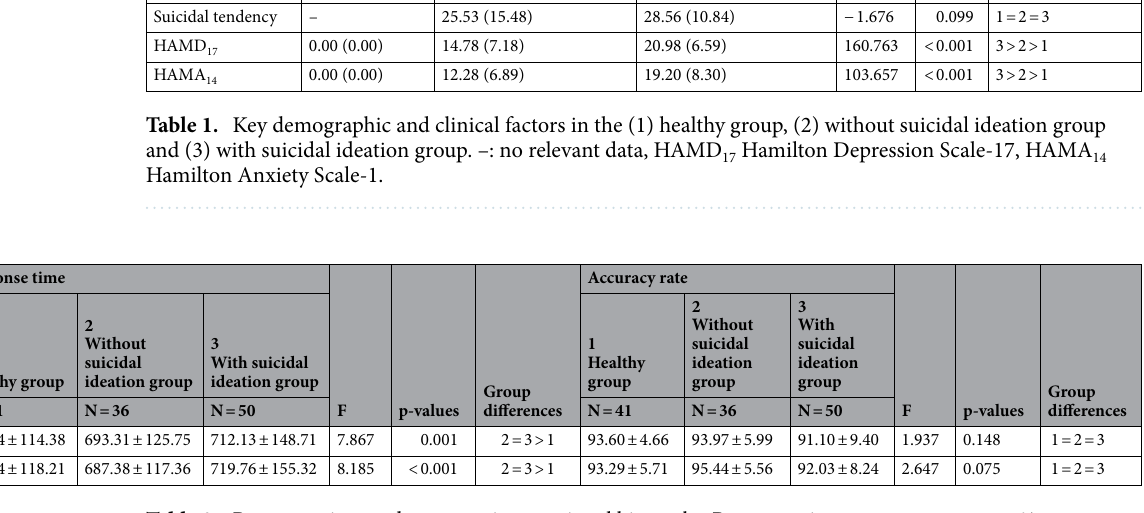
Table 2. Response time and accuracy in attentional bias tasks. Response time: ms; accuracy rate: %